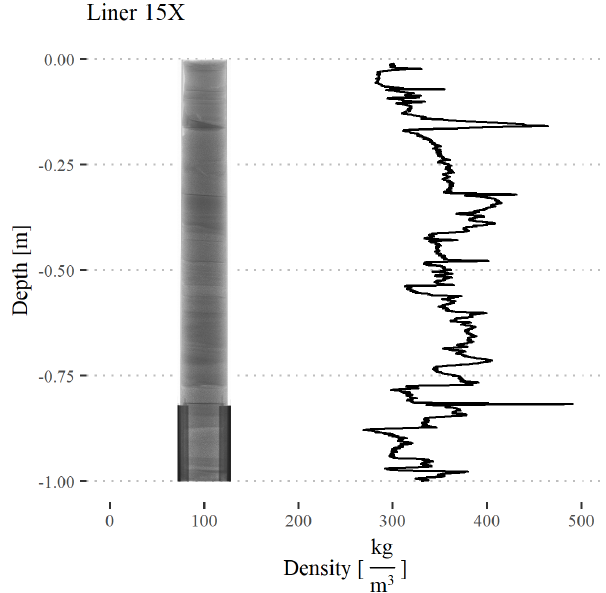
Figure A1. µ CT density of a snow profile at position 15X. On the left the radioscopic image of the snow profile is visible. Dark grey color represents high-density values, and bright grey represents low- density values. On the right, the corresponding density profile over depth is